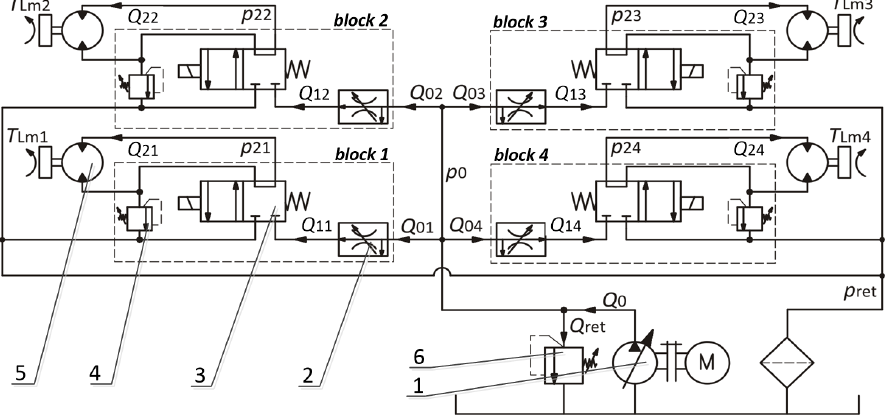
Figure 2. Hydraulic system diagram: 1—supply unit with a single pump; 2—flow control valve; 3—electromagnetic control valve; 4, 6—relief valve; 5—hydraulic